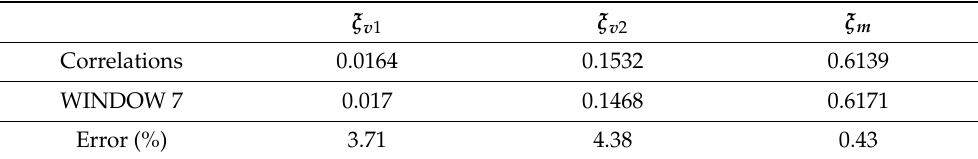
Table 4. Comparison between the values of the solar radiation absorption coefficients for the two glazings and the solar wall calculated by the correlations and those obtained with the WINDOW